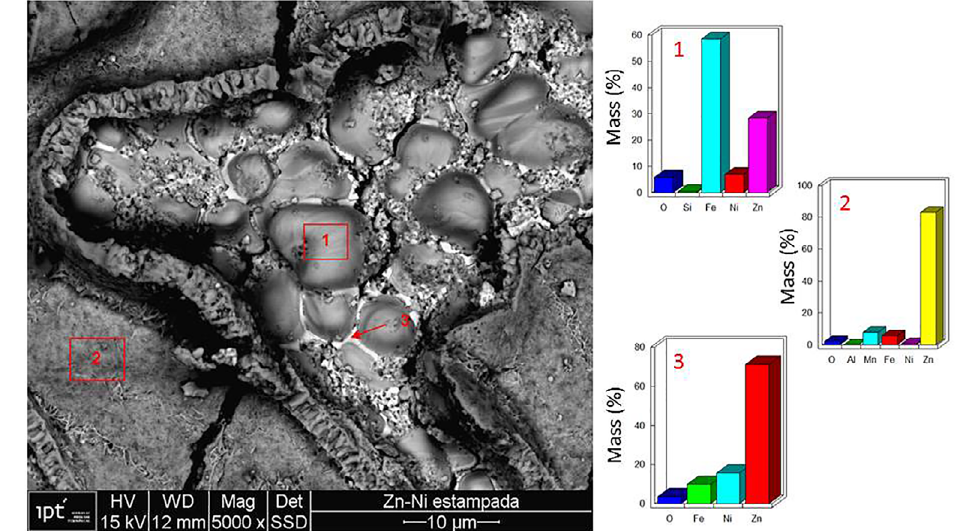
Figure 4. Details of the surface of the 22MnB5 steel electroplated with Zn-Ni coating after hot stamping, showing different aspects of the